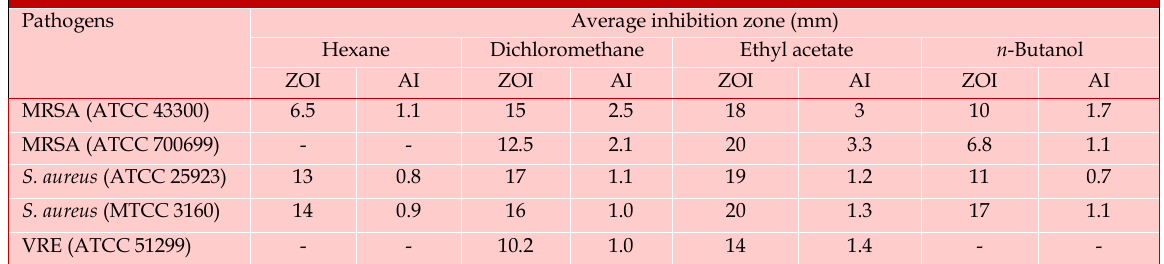
Average inhibition zone and activity index of PTR3 ethyl acetate extract (100 µg/mL) Pathogens